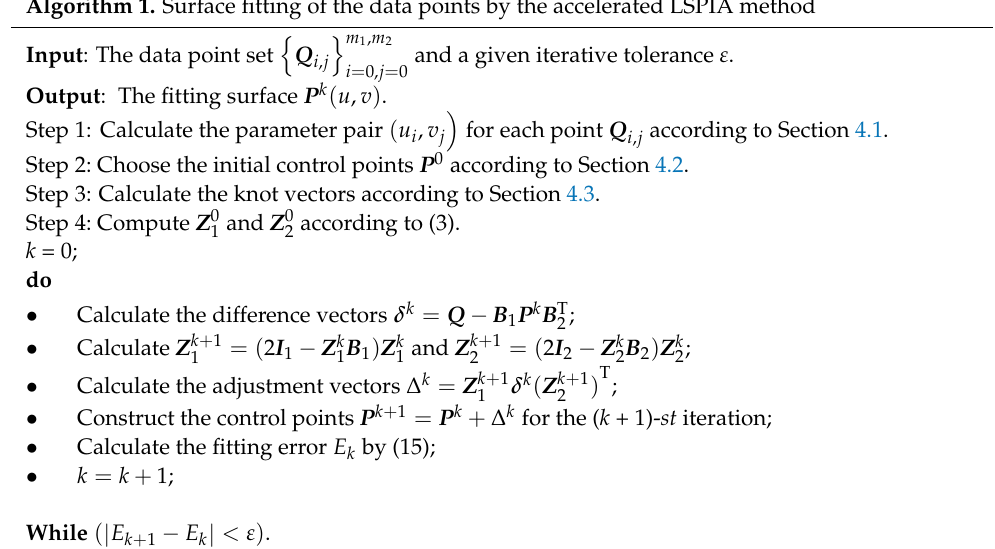
Algorithm 1. Surface fitting of the data points by the accelerated LSPIA